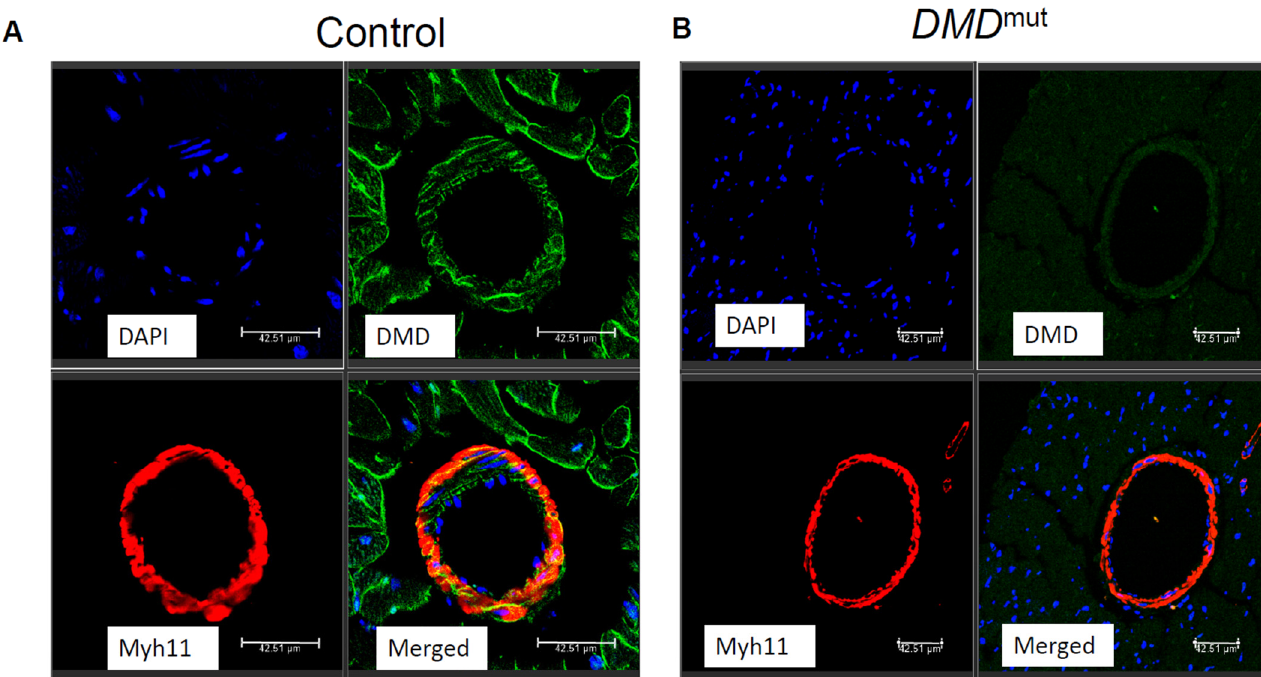
Figure 1. DMD expression in vascular smooth muscle cells from cross section in the hearts of WT and Mdx mice. ( A ) DMD protein expression in the WT heart. ( B ) DMD protein expression in the DMD mut heart.